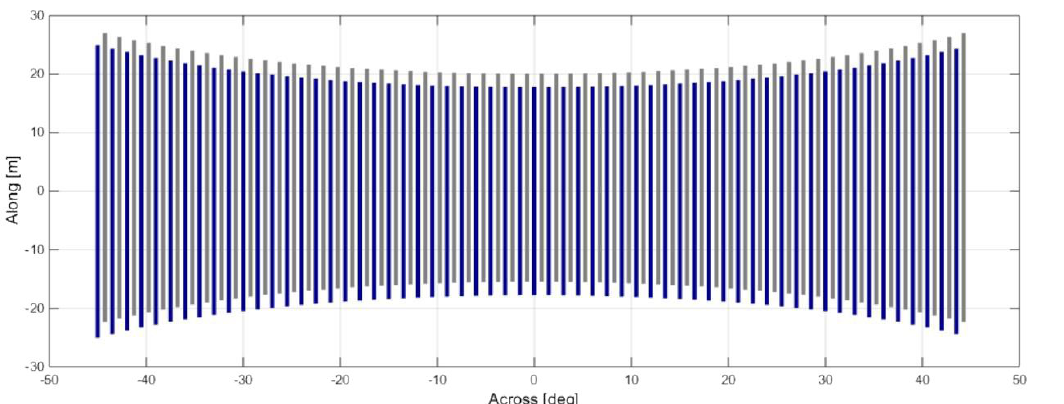
Figure 24. TX footprint for two swaths (Dual swath mode) at 1000 m depth.